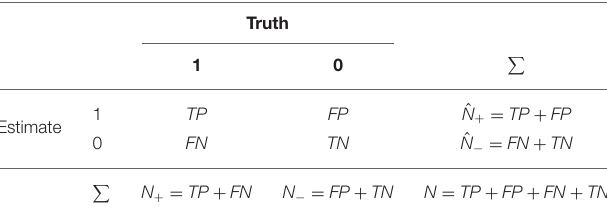
is the number of true positives, +